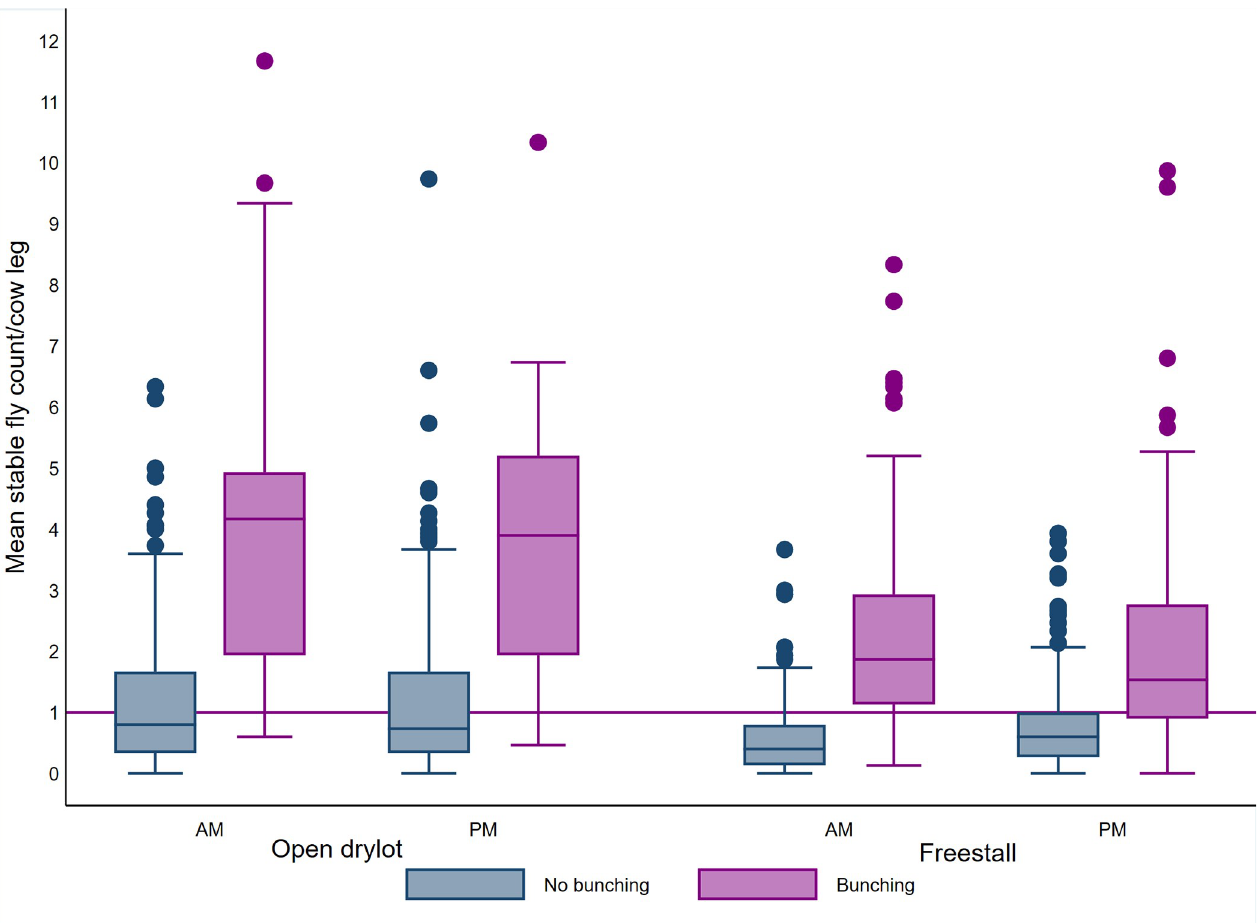
Fig 2. Schematic presentation of a longitudinal study of cow bunching using cow leg fly count at the pen level. Pens were nested within dairies, which were nested within observers. For example, nesting implies that pen 1 in dairy 1 differs than pen 1 in other dairies. Pens were also crossed by time of day which were nested within week. For example, crossing implies that the AM bunching observations completed at the same morning on all the pens in all the dairies.